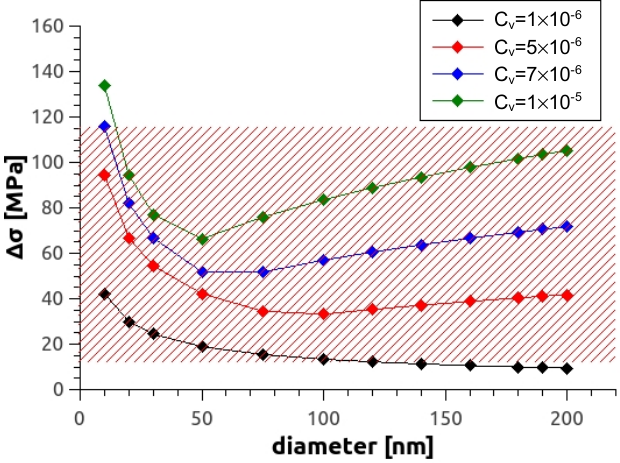
Figure 12. Increase of strength as a function of loop diameter at various vacancy concentrations. The red shaded area represents values of possible vacancy-induced strength in investigations [8,15] and the current one.